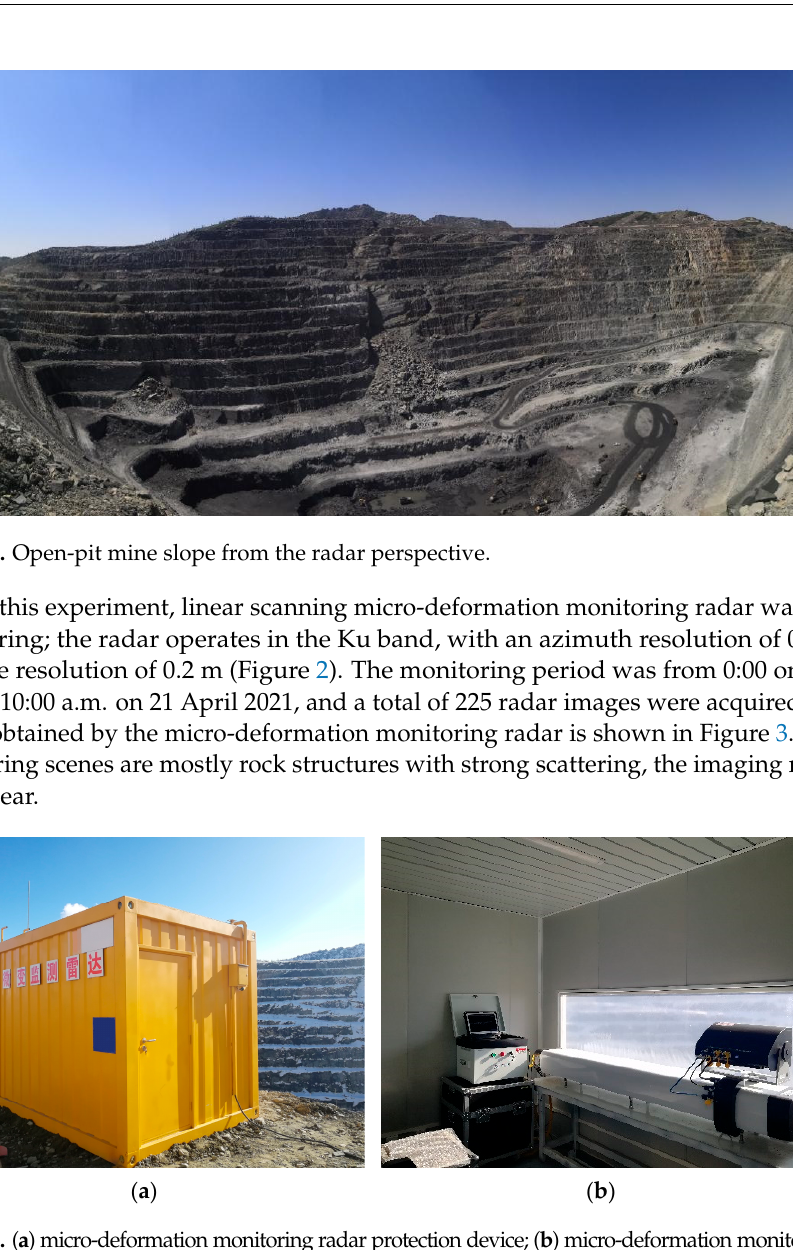
Figure 2. ( a ) micro-deformation monitoring radar protection device; ( b ) micro-deformation monitoring radar.